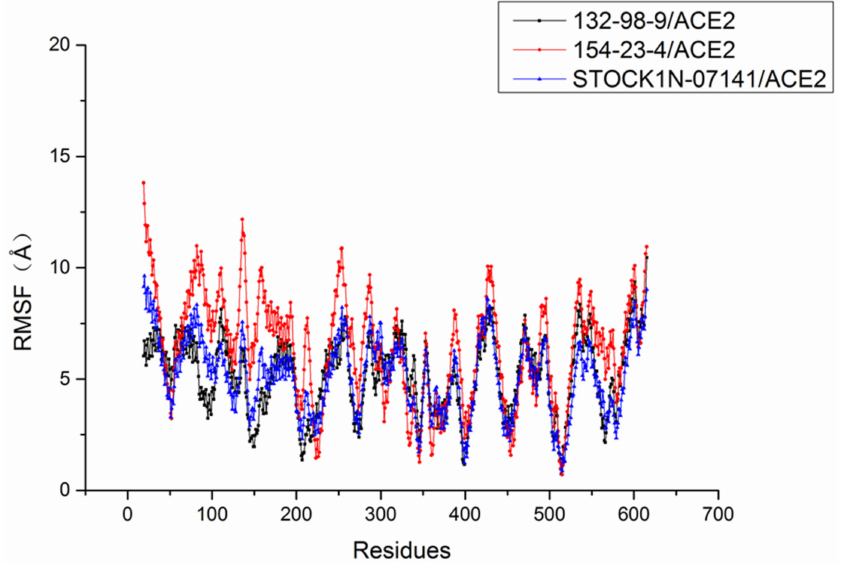
Figure 6. Root mean square fluctuation (RMSF) of each system. Table 4. Binding free energy (kcal/mol) of each system, and the energy contribution of each component.